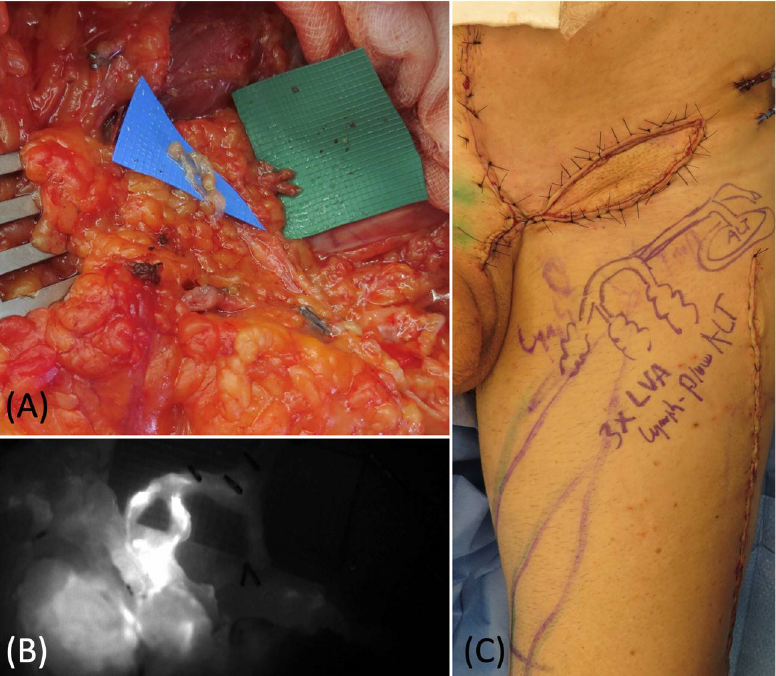
Figure 5. ( A ) Lymphovenous anastomoses of 2 superficial lymphatics and 1 deep lymphatic with 3 branches of the pedicle vein. ( B ) Intraoperative ICG lymphography to confirm the patency of the anastomoses. ( C ) Picture of the groin at the end of the procedure: the ALT flap was inset and 3 LVAs were performed with 3 pedicles branches.